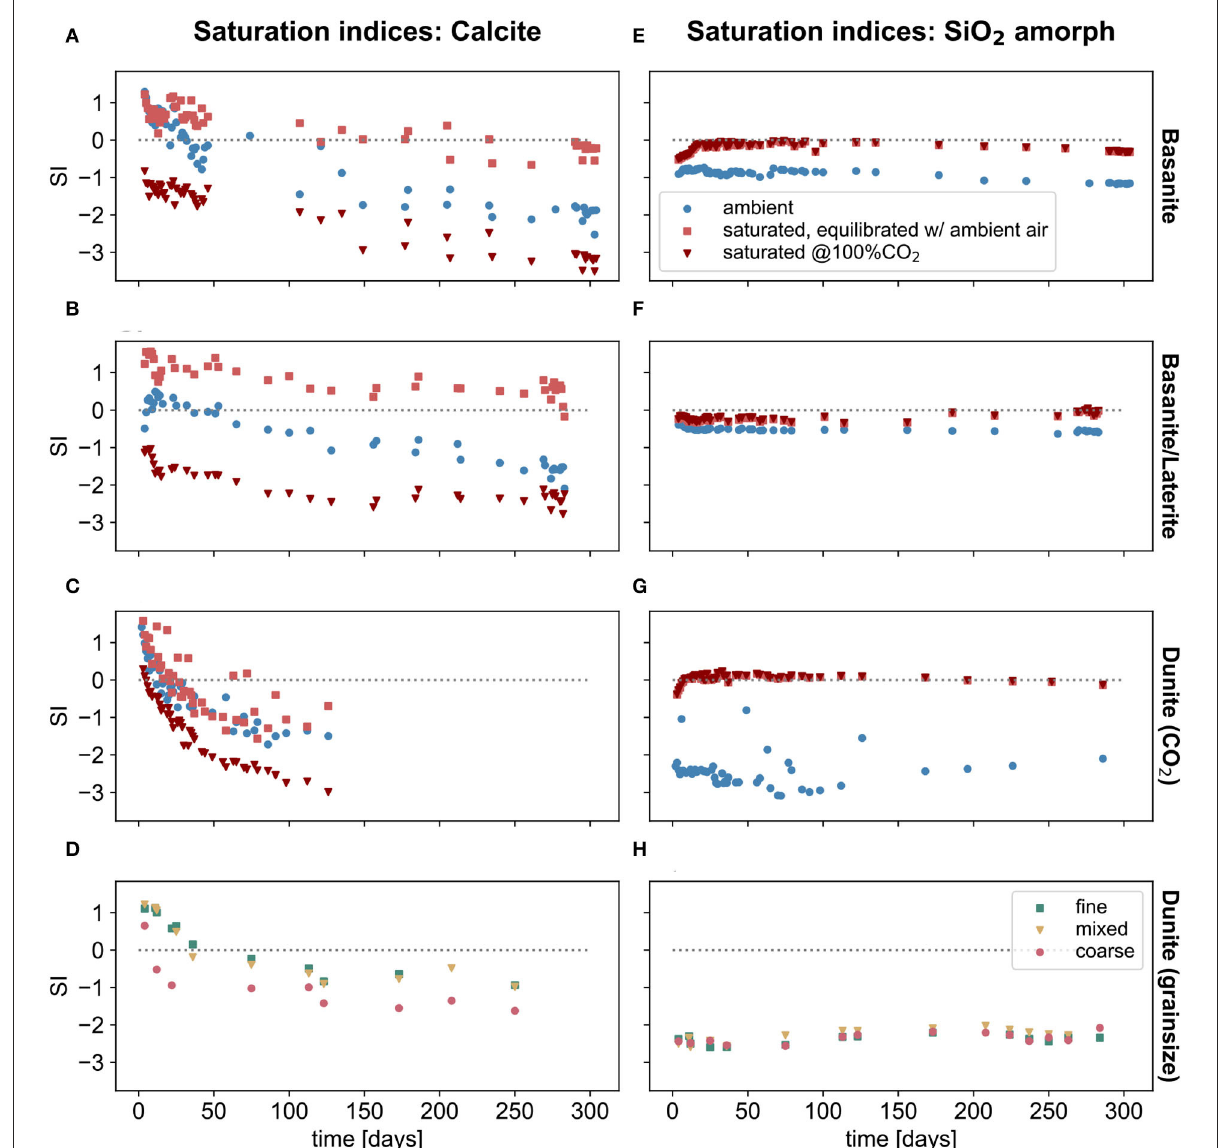
FIGURE7 Calculated saturation indices for calcite (A–D) and amorphous silica (E–H) based on the composition of the outflow solution of the column experiments. Values were calculated using PhreeqC. Ambient and saturated values in (A–C,E,F) are calculated based on the outflow solution, which was equilibrated for 24h or longer with the laboratory atmosphere. In addition, saturation indices were calculated assuming the effluent solutions remained CO 2